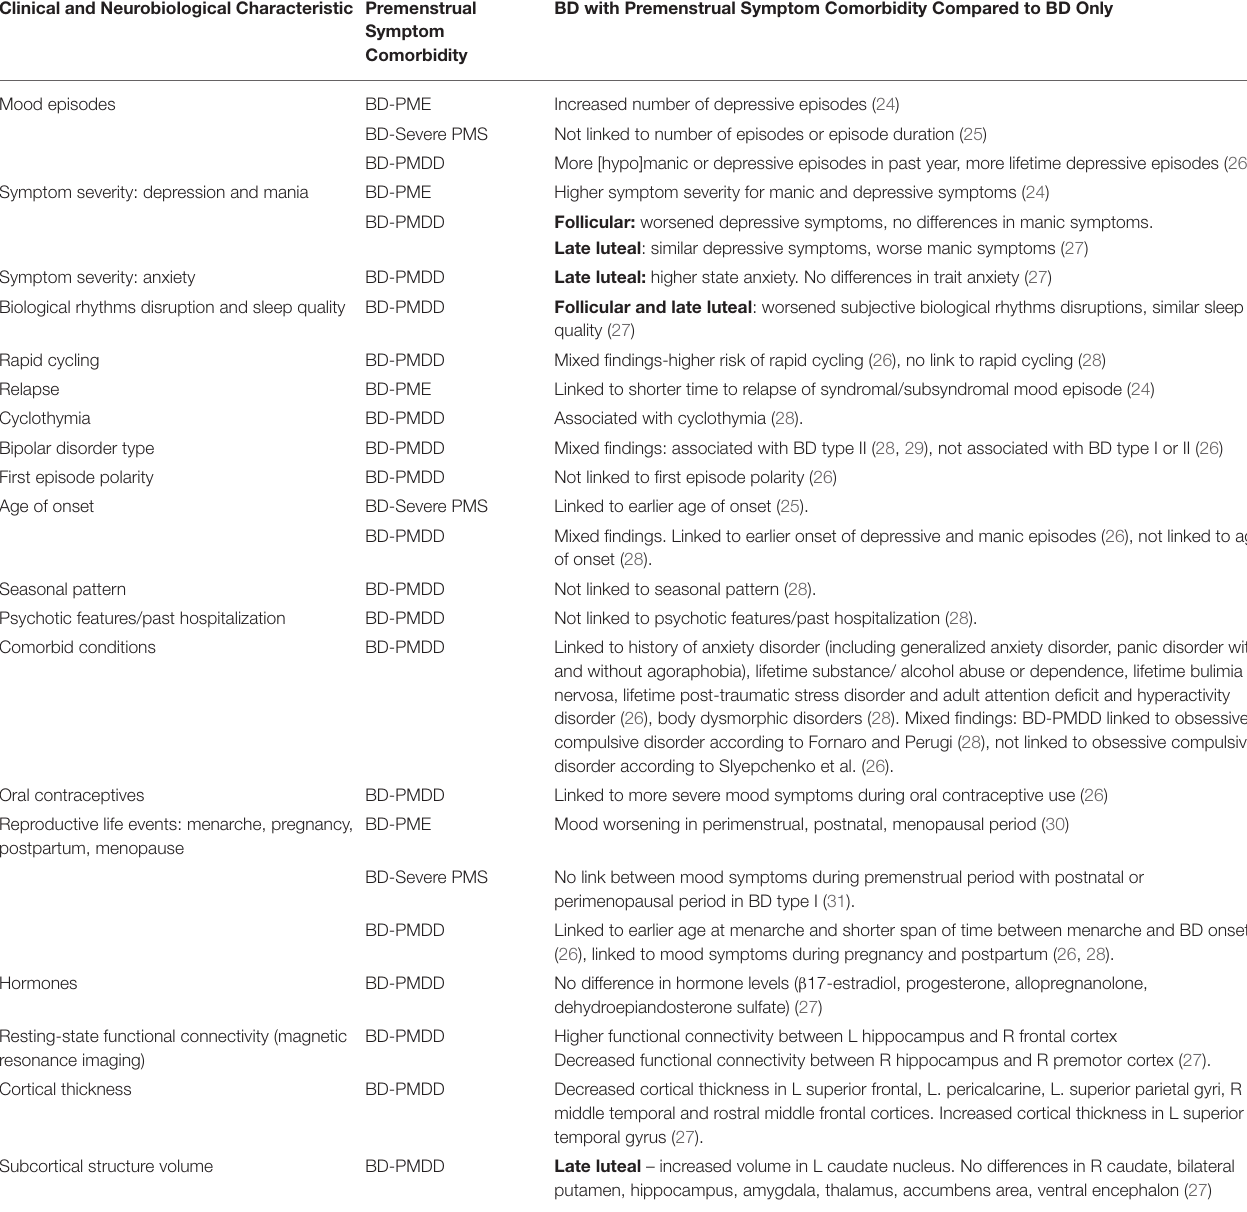
TABLE 1 | Clinical and neurobiological characteristics associated with premenstrual exacerbation, severe premenstrual symptoms, and premenstrual dysphoric disorder in bipolar disorder. Clinical and Neurobiological Characteristic Premenstrual